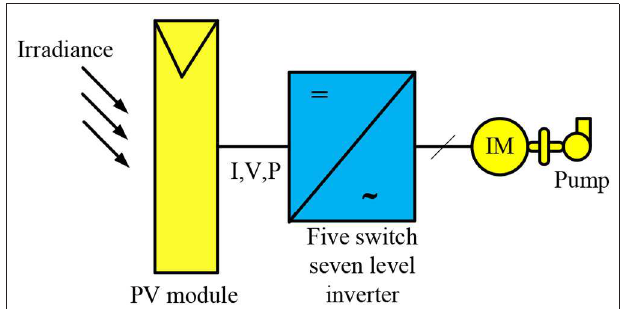
FIGURE 1 | A framework of the proposed system.